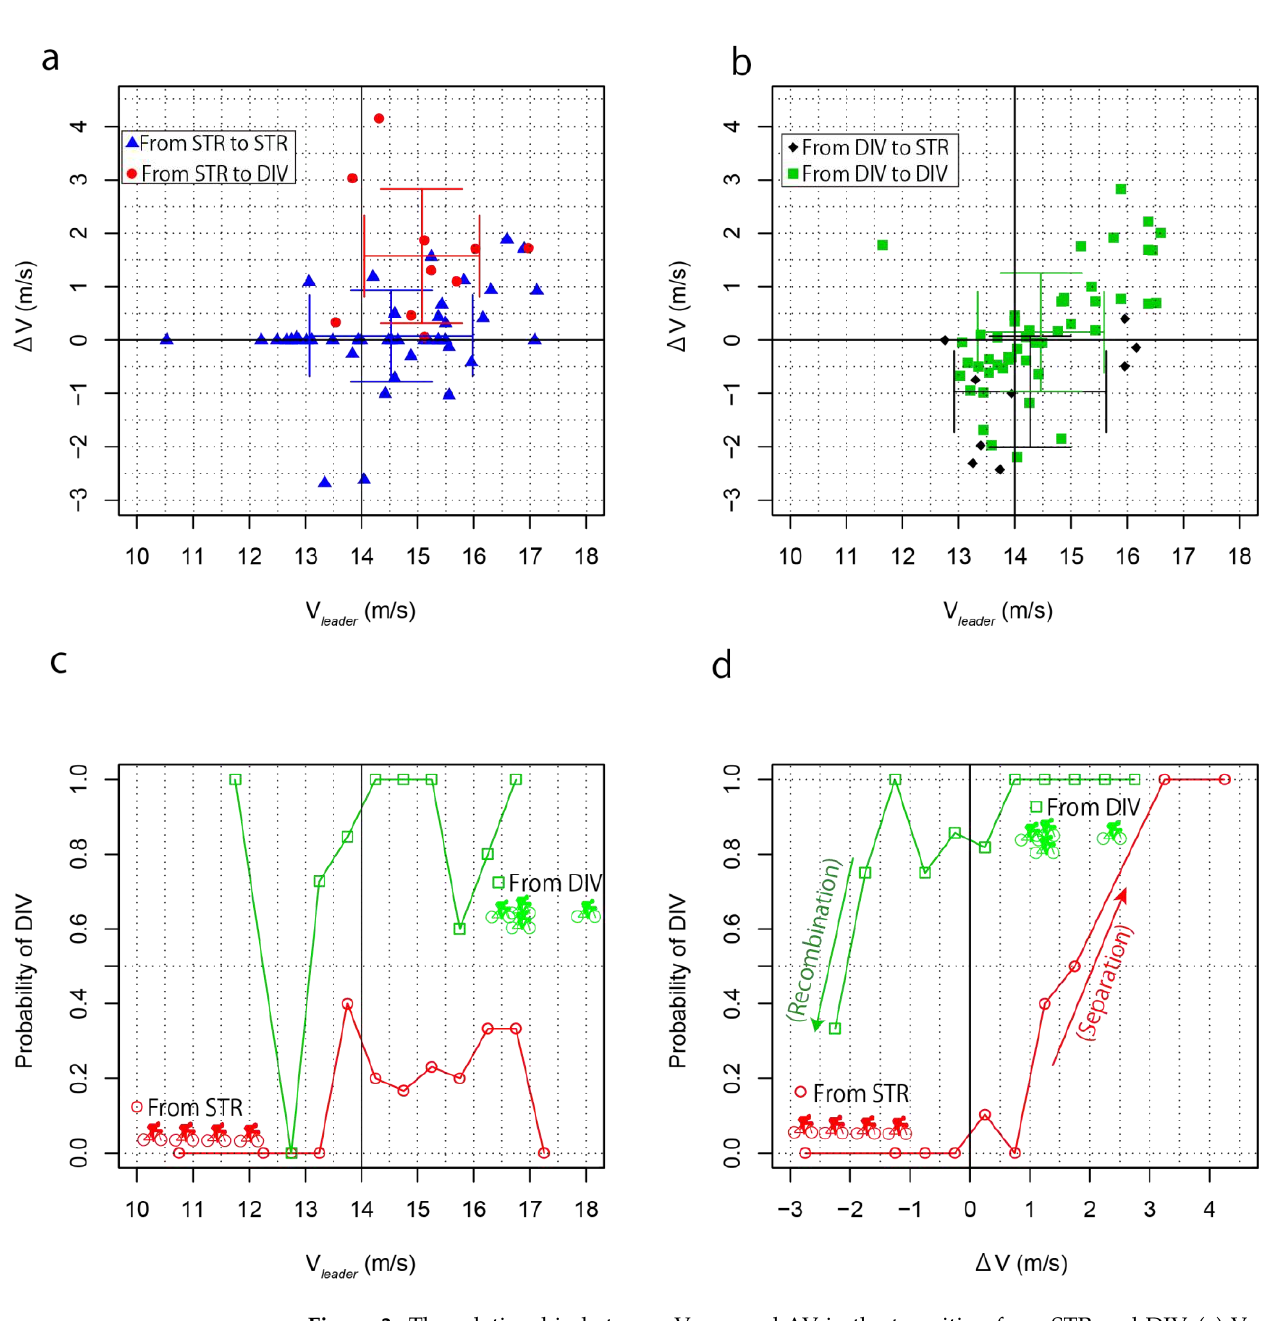
Figure 3. The relationship between V leader and ∆ V in the transition from STR and DIV. ( a ) V leader and ∆ V when staying STR (blue) and transitioning from STR to DIV (red). ( b ) V leader and ∆ V when staying DIV (green) and transitioning from DIV to STR (black). A crossing point of the error bar shows the mean value, and the width of the error bar shows the standard deviation. The median of V leader is 14 m/s. ( c ) The probability of DIV for V leader when transitioning from STR (red) and DIV (green). For V leader , in the grid with 0.5 m/s in ( a ) and ( b ), the probability of transitioning to a divided state was calculated. ( d ) The probability of DIV for ∆ V when transitioning from STR (red) to DIV (green). For ∆ V, in the grid of 0.5 m/s in ( a ) and ( b ), the probability of transitioning to a divided state was calculated.